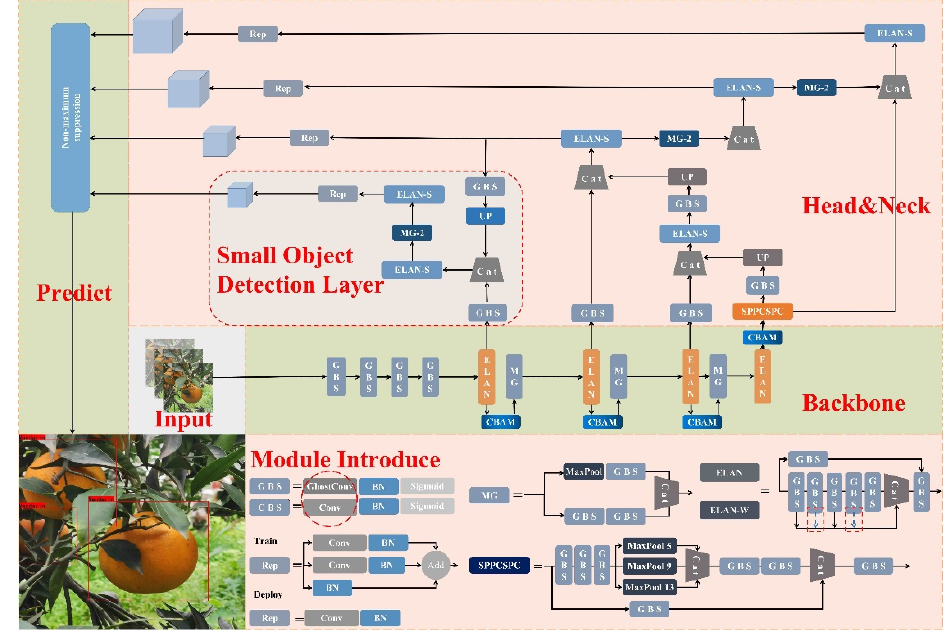
Figure 6. Citrus-YOLOv7 Network architecture.